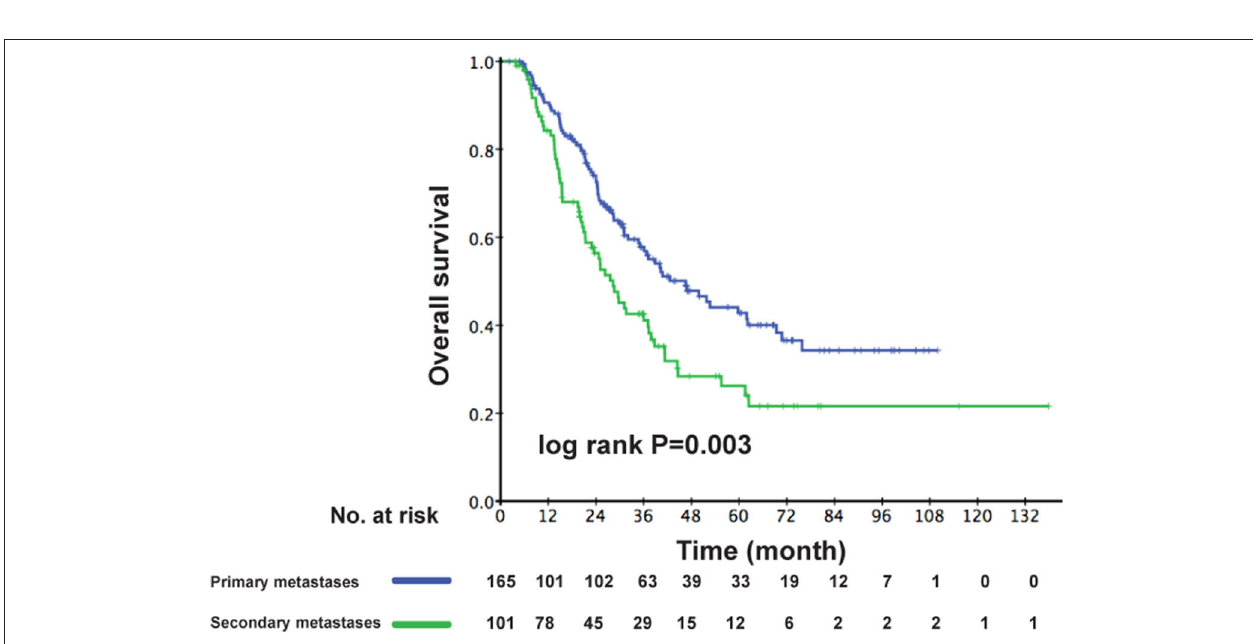
FIGURE 4 | Kaplan–Meier OS curves for patients with primary metastases and secondary metastases. OS, overall